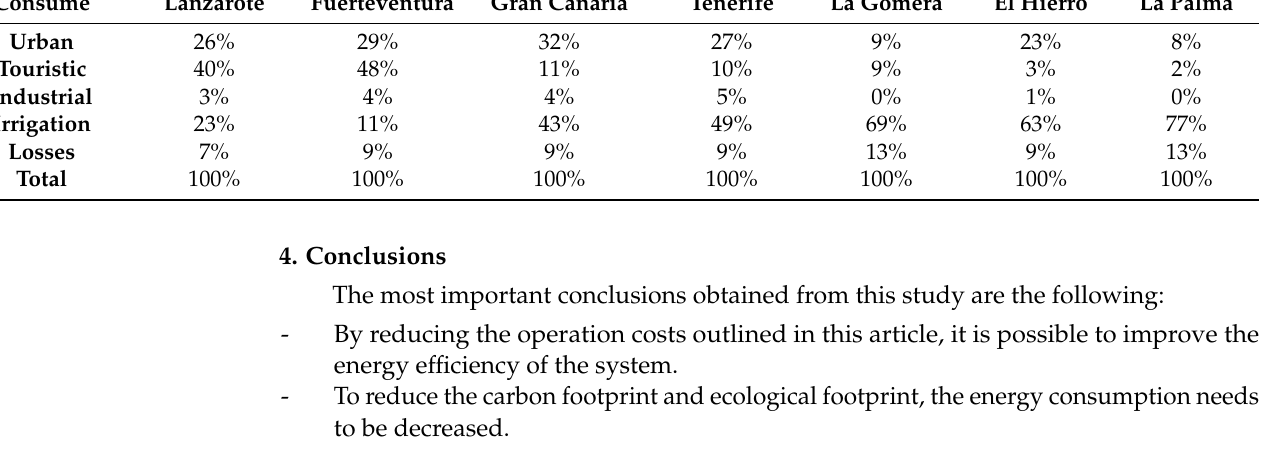
Table 11. Percentages of water consumption by islands and sectors (%) (2017) [15]. Water Consumes in Canarias per Sectors